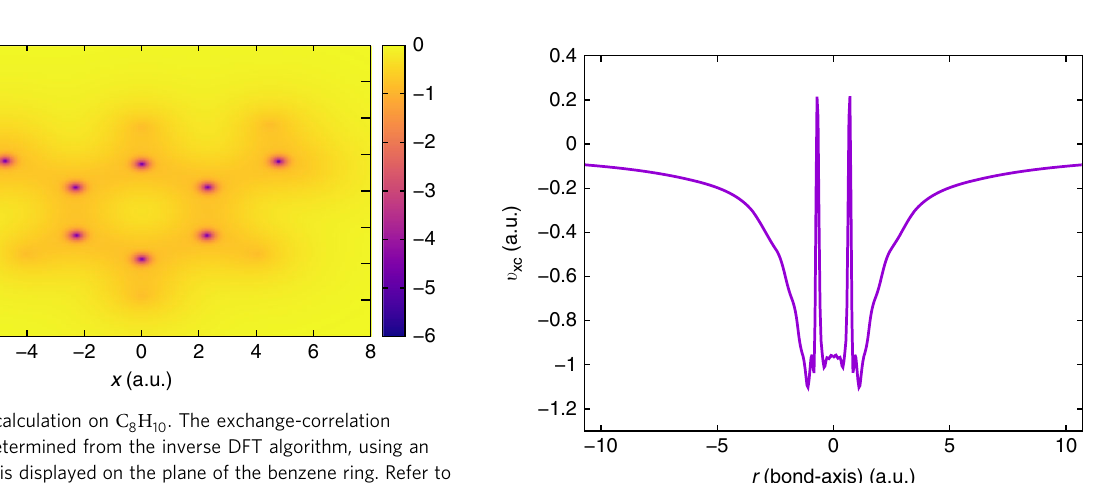
Fig. 2 Veri fi cation study on atomic systems using LDA-based density. The density ( ρ functional. The solid line corresponds to the direct evaluation of the LDA exchange-correlation potential corresponding to ρ line corresponds to the exchange-correlation potential obtained from the inverse DFT calculation using ρ